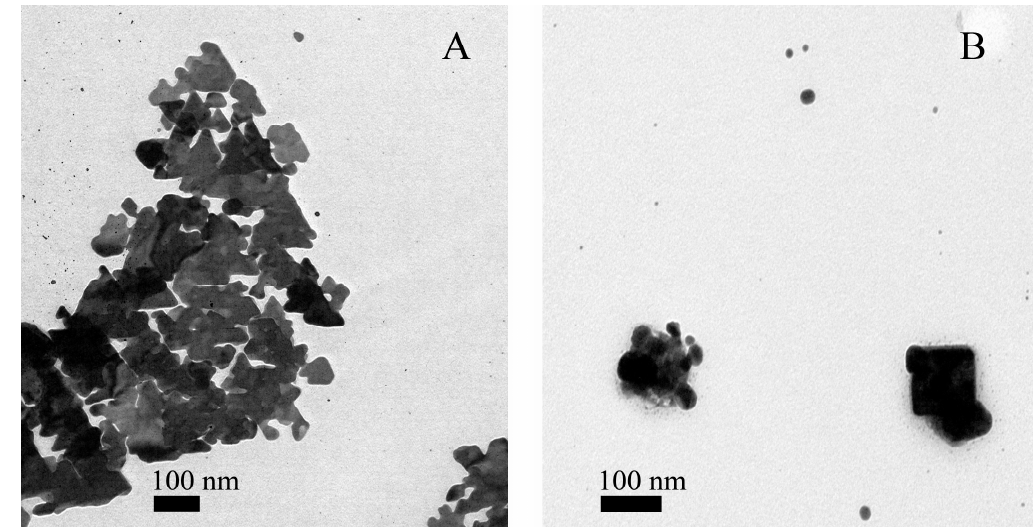
Figure 5. Representative transmission electron microscopy (TEM) images of AgNPs. ( A ) NCG-AgNPs; ( B ) PhCG-AgNPs.